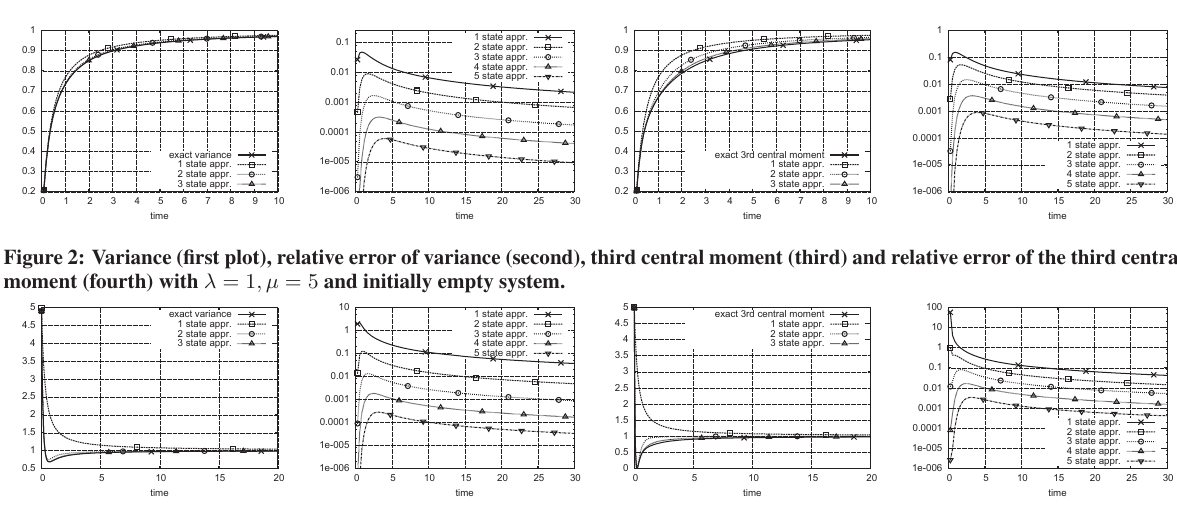
Figure 3: Variance (first plot), relative error of variance (second), third central moment (third) and relative error of the third central moment (fourth) with λ = 1 ,μ = 5 and with initially one client in the system. where X ( t ) is the number of events up to time t . Thanks to the division by t these quantities tend to a constant value as t tends to